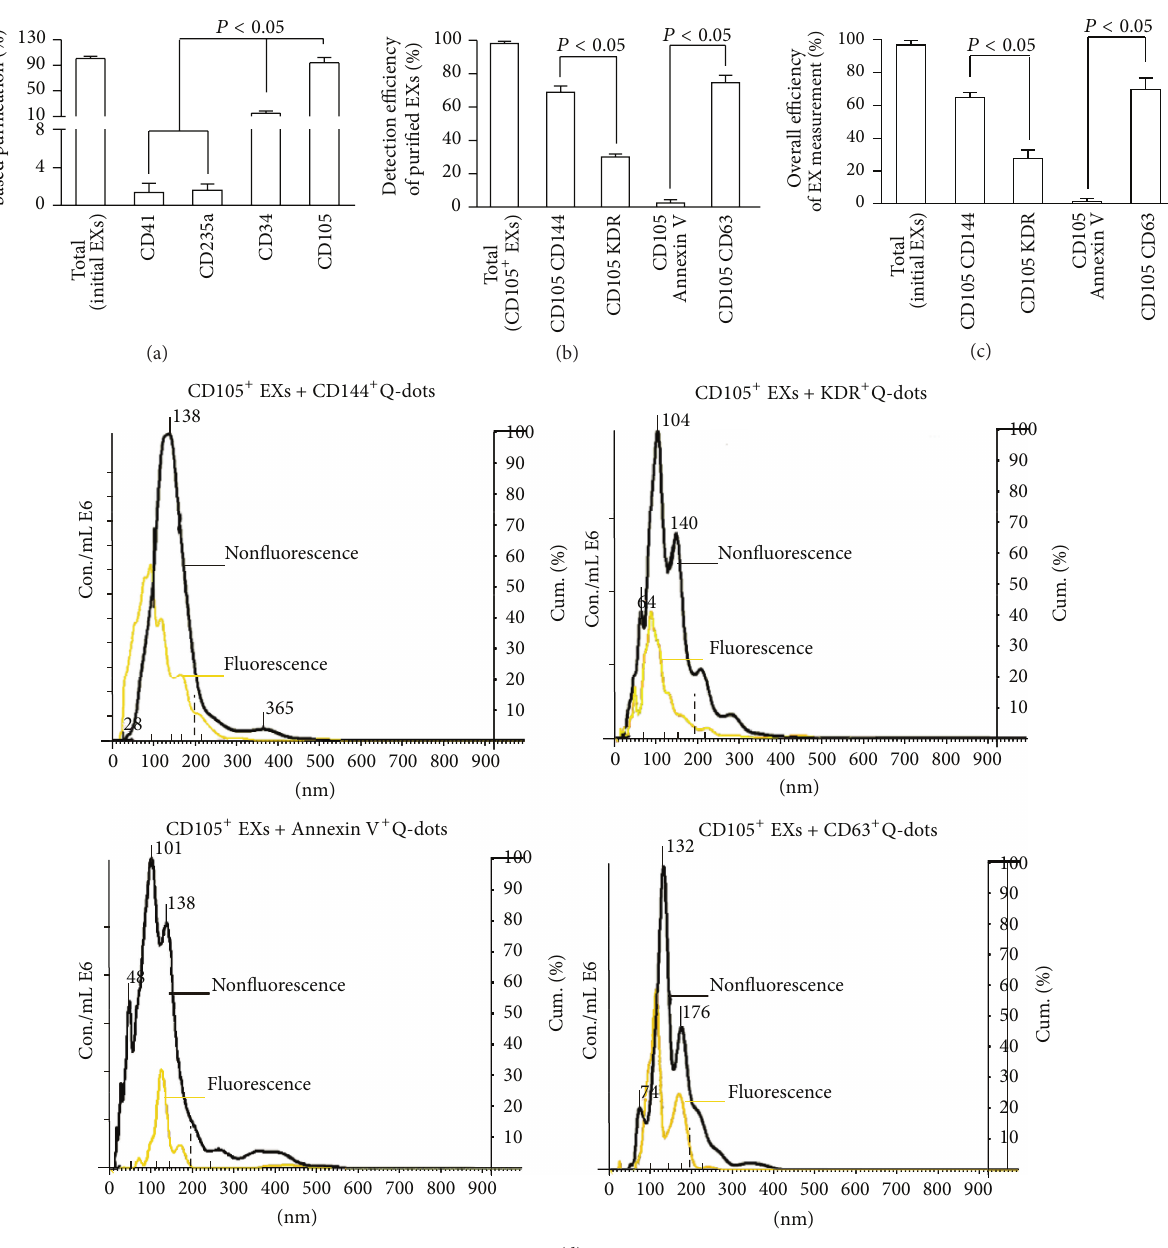
Figure 2: The efficiencies and specificities of the methods by combining microbeads with NTA for purifying and detecting EC-EXs. (a) The purification efficiency and specificity of EC-EXs in the total EC-EXs, which were collected from EC culture medium by ultracentrifuge and isolated by various microbeads-conjugated antibodies against EC specific markers (CD105, as well as negative controls, CD34, CD41, and CD235a). (b) The detection efficiency and specificity of EC-EXs in the total CD105 + EXs that were labeled with CD144-, or KDR-, or Annexin V-, or CD63-conjugated Q-dots upon detection by fluorescence NTA. (c) The overall efficiency for measuring the CD105 + EXs colabeled with CD144-, or KDR-, or Annexin V-, or CD63-conjugated Q-dots in the total EC-EXs. (d) Representative plots showing the size/concentration distribution of the CD105 + beads isolated EXs under fluorescence/nonfluorescence modes. Black curve: CD105 + EXs measured under light scatter (nonfluorescence) mode. Yellow curve: CD105 + Q-dots + EXs measured under fluorescence mode. Black dash line: 200 nm landmark. 𝑁 = 4 /group.